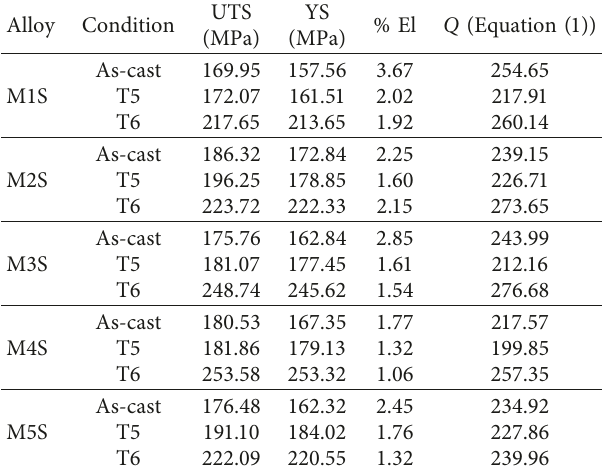
Table 6: Variation in average UTS, YS, % El, and Q values of the alloys studied in as-cast and T5- and T6-treated conditions ob- tained at 250 °